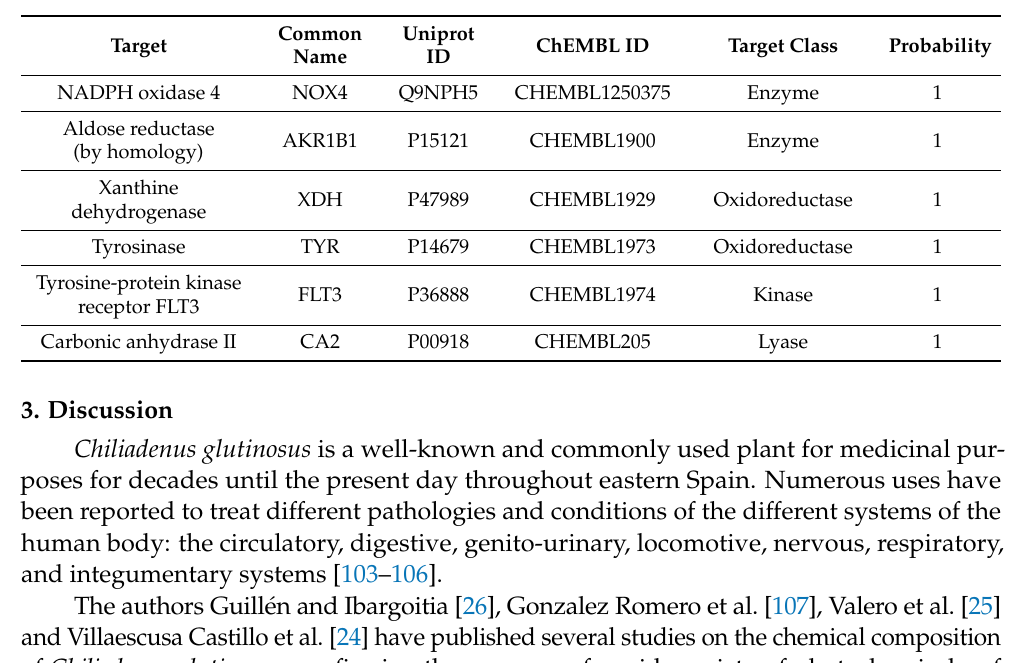
Table 13. Main molecular targets of the phytochemical kaempferol obtained through the analysis in Swiss Target Prediction